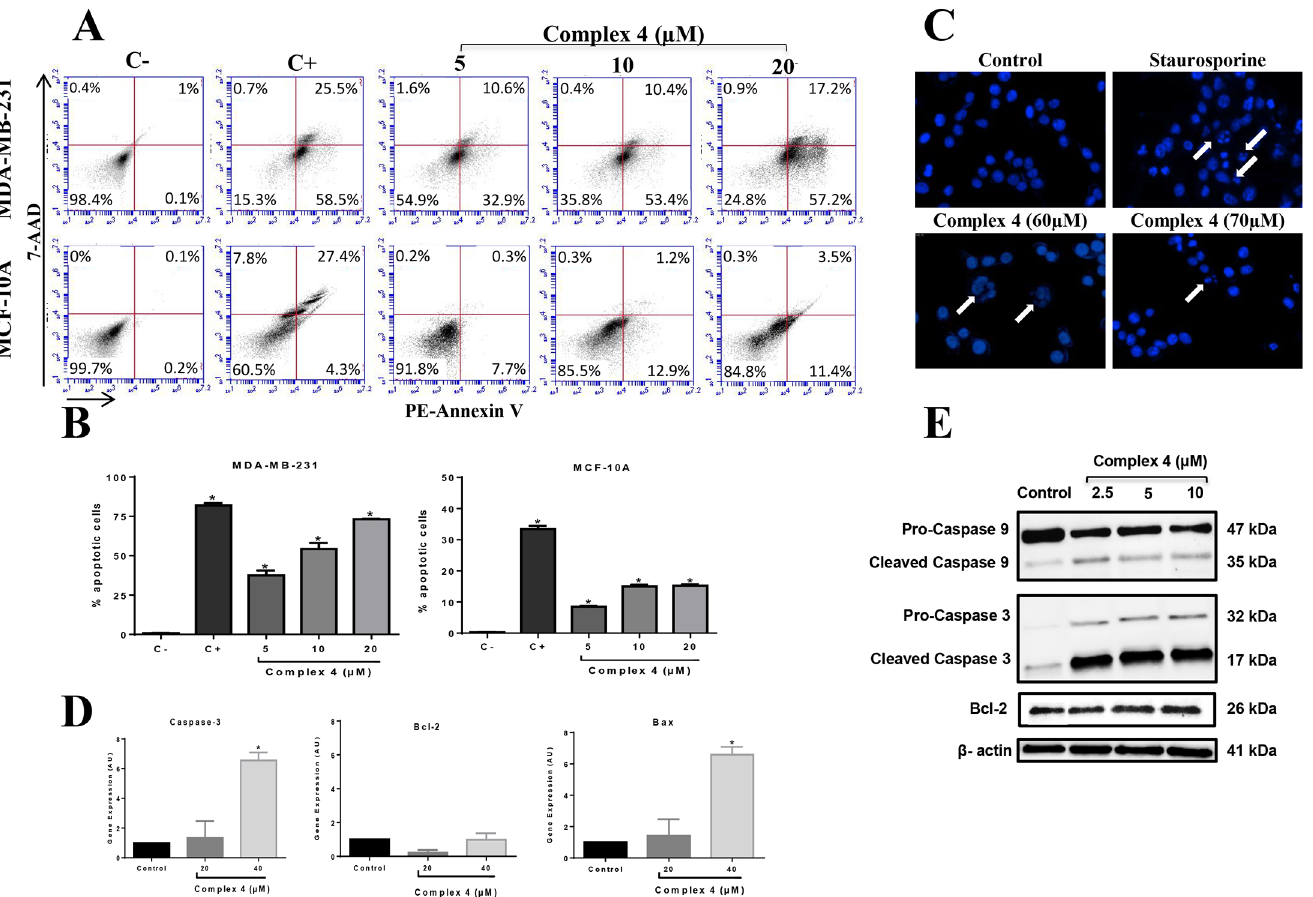
Fig 5. Effect of complex (4) on apoptosis in MDA-MB-231 breast tumor cells and MCF-10A non-tumor breast cells. (A) After treatment with the indicatedconcentrations of complex (4) , cells were incubatedwith PE-Annexin-V and 7AAD for 15min, harvestedand then analyzedby cytometry. (B) The percentageof apoptotic and necrotic cells was plotted in a graph for MDA-MB-231 and MCF-10A cells. The fluorescence of 7AAD is detected in the FL3-A channeland the fluorescence of PE-Annexin-V is detected in the FL2-A channel. Camptothecin (campto) was used as a positive control for apoptosis. (C) Nuclear fragmentation promotedby complex (4) in MDA-MB-231 cells was investigatedusing DAPI staining.Staurosporine was used as a positive control for nuclearfragmentation. White arrows show fragmented nuclei. The expressionof apoptotic and anti-apoptotic moleculeswas investigatedby (D) qRT-PCR and (E) Western blotting analysis. Significantat the * p < 0.005, ** p < 0.001, *** p < 0.0001 levels using ANOVA and Bonferroni tests.